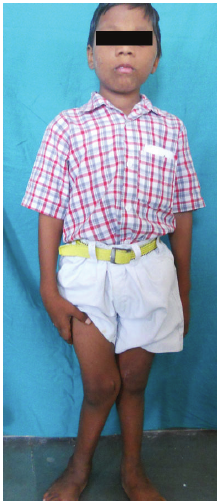
Figure 5: Showing genu valgum.